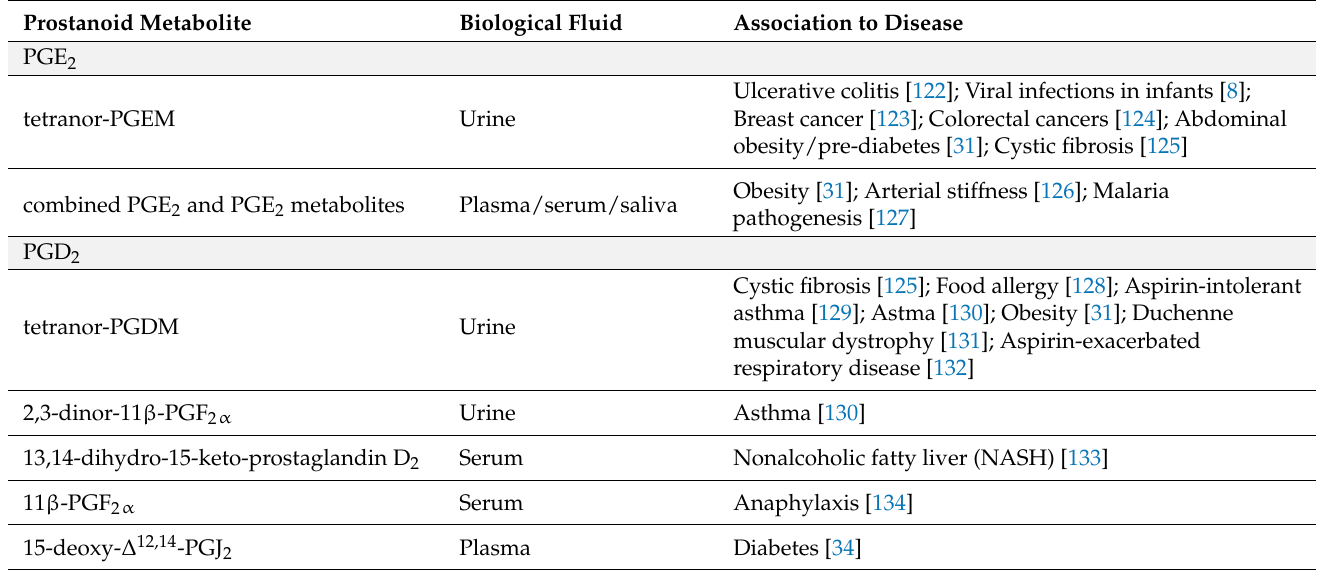
Table 2. Prostanoid metabolites as urinary/plasma biomarkers in human disease. Prostanoid Metabolite Biological